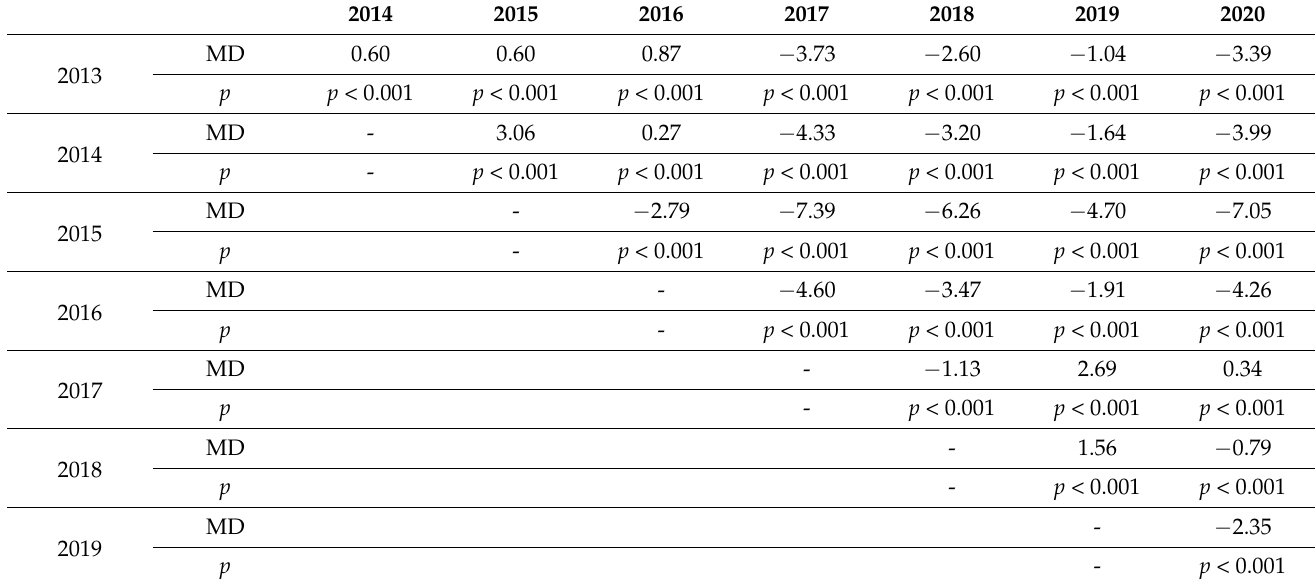
Table 9. Comparison of the safety of defibrillation between individual editions of the